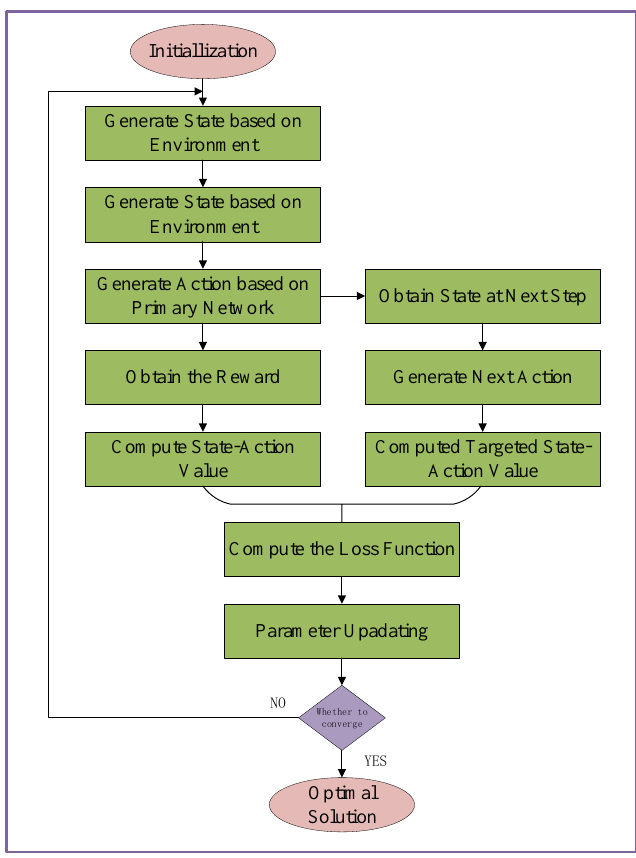
Figure 4. The flow chart of Deep Reinforcement Learning (DRL)-based Double Deep Q Network (DDQN)